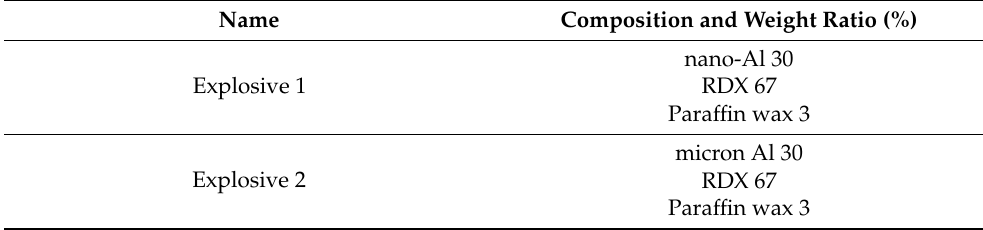
Figure 1. Photography of nano-Al ( A ) and micron-Al ( B ) powders. ( C ) TEM tests of nano-Al and ( D ) the distribution of the diameter of nano-Al powder. Paraffin wax is used as the insensitive agent to reduce the sensitivity of RDX. The component and proportions of the explosives are shown in Table 1. Table 1. Components and proportions of the two kinds of explosives samples.